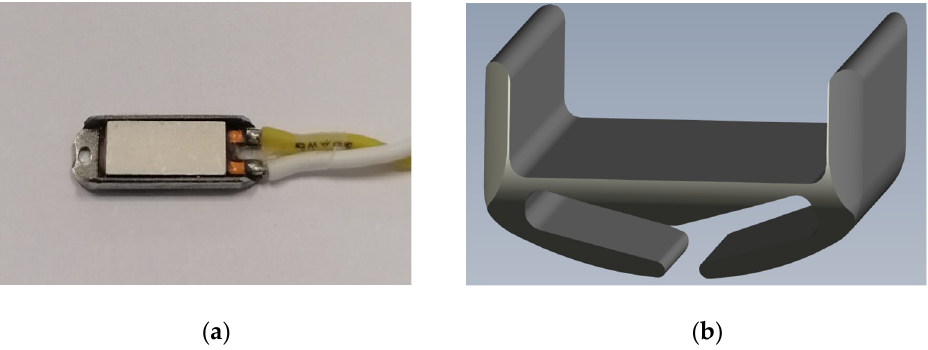
Figure 1. The ablation unit based on two mechanically bounded piezoceramic transducers electrically connected to a Kapton flexible printed circuit and housed in a metal support. ( a ) The piezoceramic transducer; ( b ) the metal support.